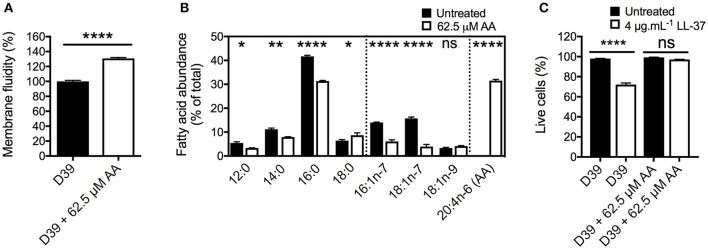
The effects of arachidonic acid on the pneumococcal membrane. (A) The membrane fluidity was determined by examining the fluorescence polarization of 1,6-diphenyl-1,3,5-hexatriene (DPH) in the cellular membrane. The relative membrane fluidity in AA-treated cells (62.5 μM) was corrected to that observed in untreated cells. (B) The major cellular fatty acid constituents of S. pneumoniae, grown in the presence of 62.5 μM AA, or without AA supplementation were determined by gas chromatography. The abundance of fatty acids is expressed as percentage of total cellular fatty acids. (C) The survival following shock-treatment with 4 μg.mL−1 LL-37 for 30 min was determined by staining with Sytox green (Molecular Probes) and subsequent flow cytometric cell counting (BD Accuri). For all panels, the data are the mean of at least biological triplicates (± SEM). For the membrane fluidity (A) and fatty acid analyses (B), statistical analyses were performed by Student's t-test (ns, not significant; *p < 0.05; **p < 0.01, and ****p < 0.0001). For the cell viability assay (C), statistical analyses were performed using a one-way ANOVA (ns, not significant; ****p < 0.0001).